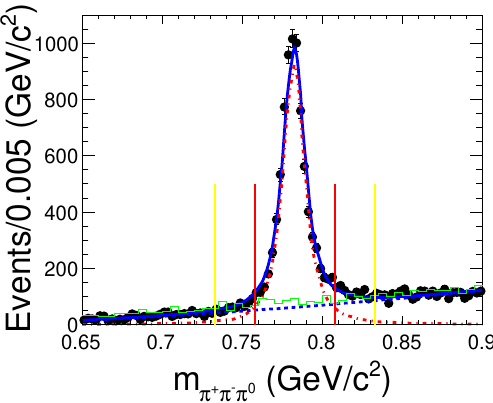
Figure 7 . The π + π − π 0 invariant mass spectrum of the process e + e − → ωπ + π − at √ s = 2.1250 GeV. The dots with error bars are the data, the red dotted curve is the signal, and the blue dashed line is the background. The blue solid curve is the best fit result. The green histogram is from the MC simulation of the non-resonant contribution from e + e − → π + π − π + π − π 0 . The range between the two red vertical solid lines is regarded as the signal region, and those between the yellow and red vertical lines on each side of the signal peak are regarded as the sideband